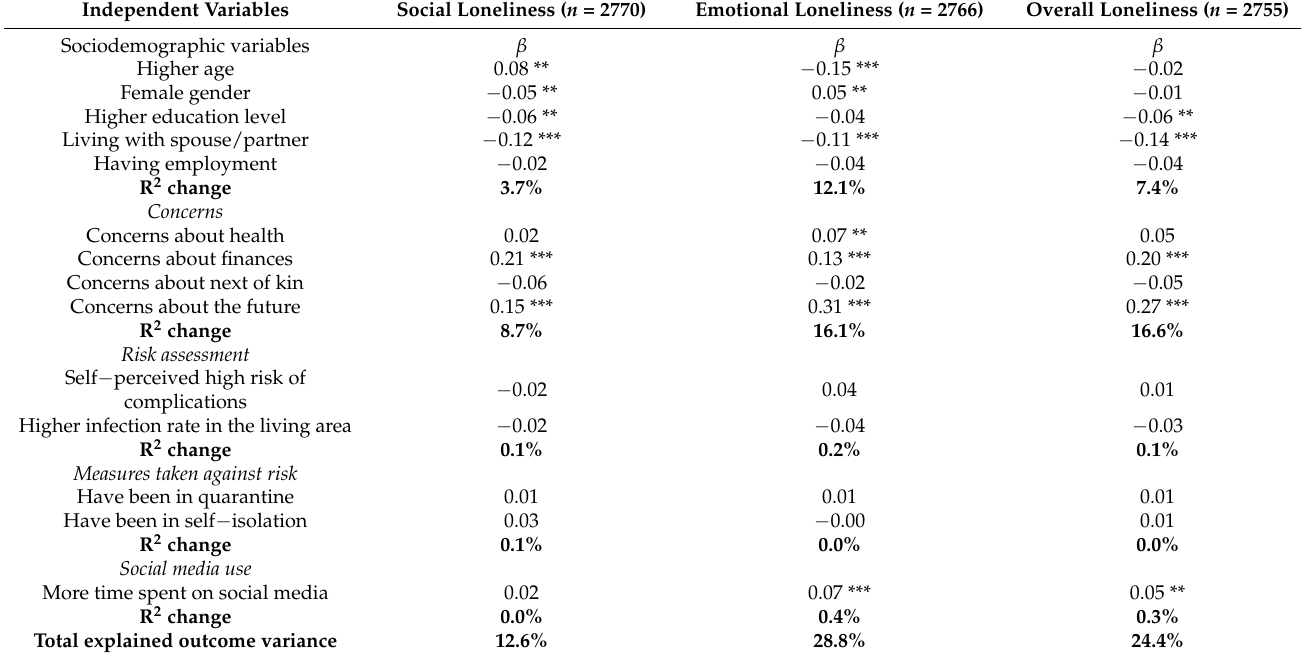
Table content is Pearson’s r . ** p < 0.01, *** p < 0.001. The results from the multiple linear regression analyses are reported in Table 3. Ad- justed by all included variables, higher levels of social loneliness were associated with concerns about finances ( β = 0.21, p < 0.001) and the future ( β = 0.15, p < 0.001). Higher lev- els of emotional loneliness were associated with concerns about health ( β = 0.07, p < 0.001), finances ( β = 0.13, p < 0.001), and the future ( β = 0.31, p < 0.001). Higher emotional loneli- ness was also associated with more time spent on social media ( β = 0.07, p < 0.001). Higher levels of overall loneliness were associated with concerns about finances ( β = 0.20, p < 0.001) and the future ( β = 0.27, p < 0.001), and with more social media use ( β = 0.05, p < 0.01). Among the sociodemographic variables, cohabitation and higher education levels were relatively consistently associated with lower levels of loneliness. Higher age was related to higher levels of social loneliness ( β = 0.08, p < 0.01) and with lower levels of emotional loneliness ( β = − 0.15, p < 0.001). Table 3. Multiple linear regression analysis showing adjusted associations with social, emotional, and overall loneliness. Independent